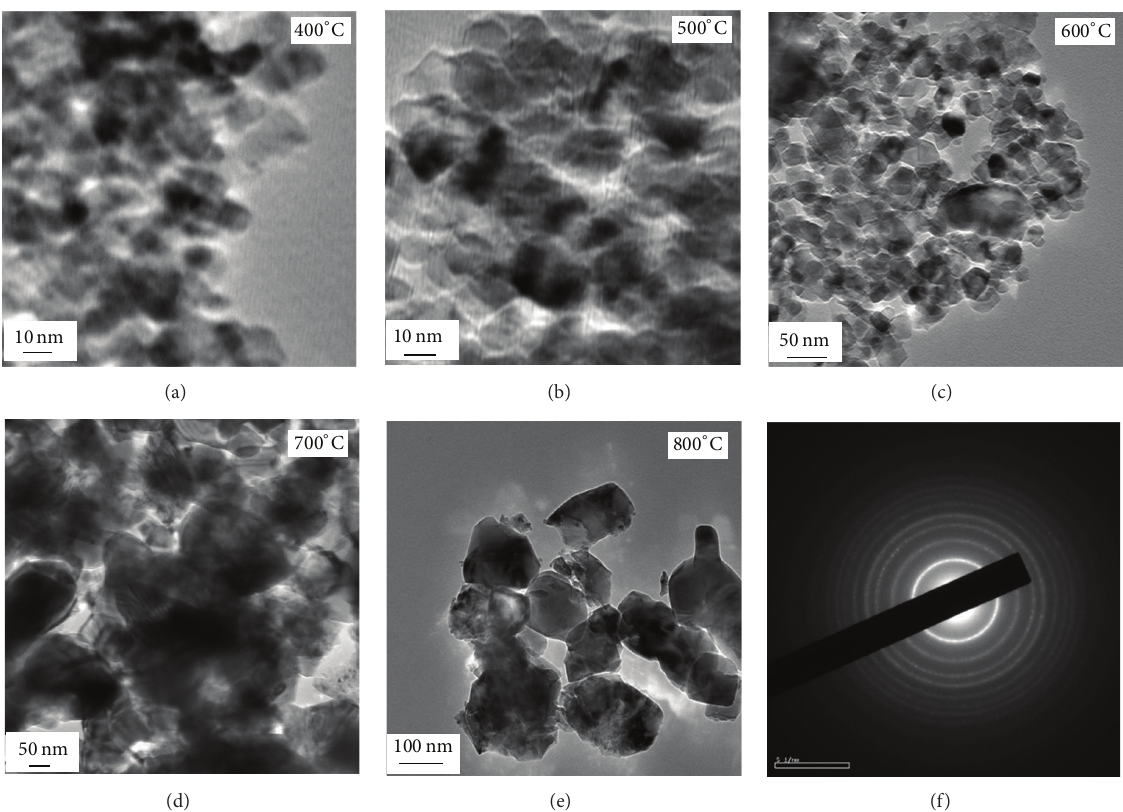
Figure 4: TEM images of N-TiO 2 prepared (a)–(e) at various calcination temperatures with 2.0 ammonia/TTIP ratio and (f) the selected area electron diffraction of